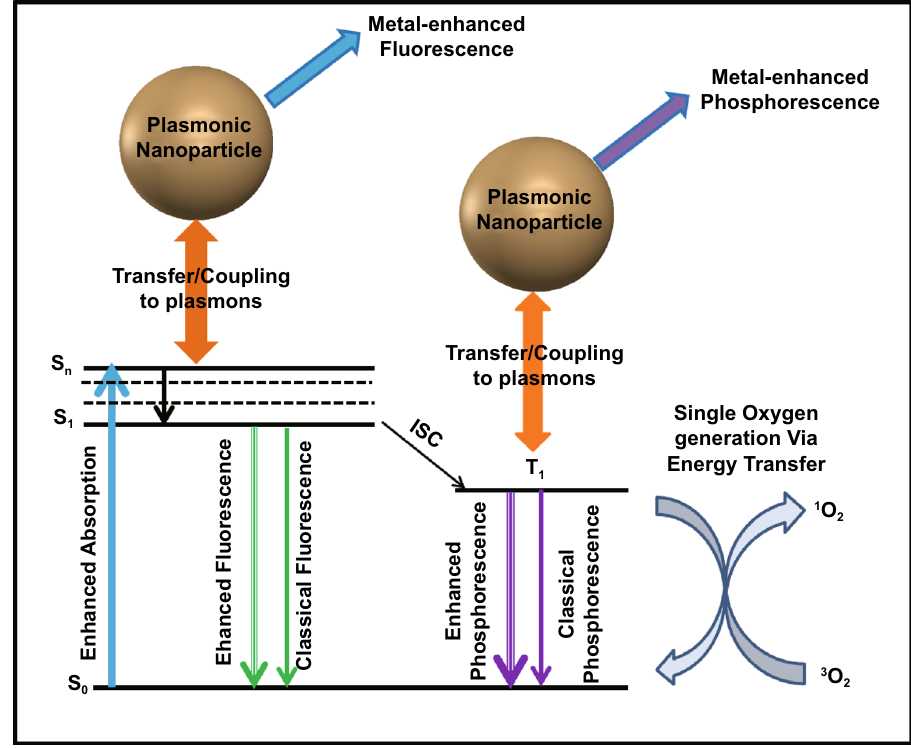
Fig. 9 Jablonski Diagram for a photosensitizer molecule in the vicinity of a metal nanostructure. S 0 , S 1 , and S n are referred to the different levels of singlet state. T 1 is the lowest level of triplet state, and ICS stands for intersystem crossing